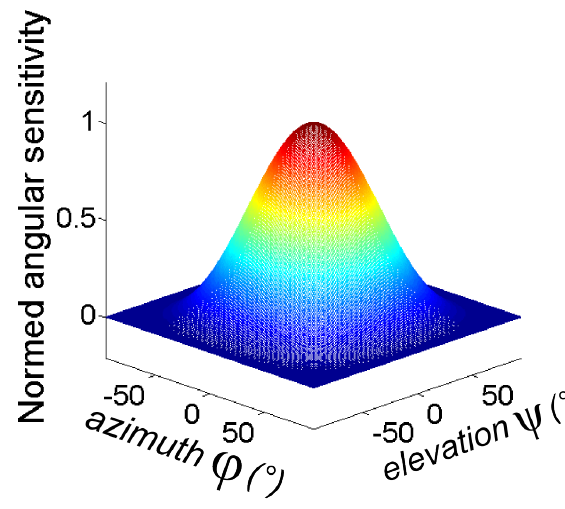
Figure 3. Cosine-like angular sensitivity of a photosensor.